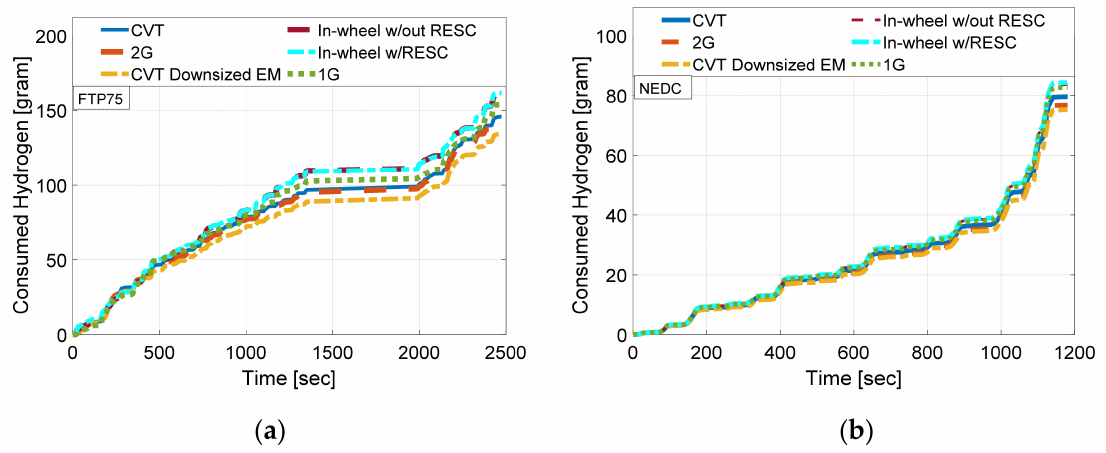
Figure 12. Comparison of the consumed hydrogen: ( a ) FTP75 drive cycle; ( b ) NEDC drive